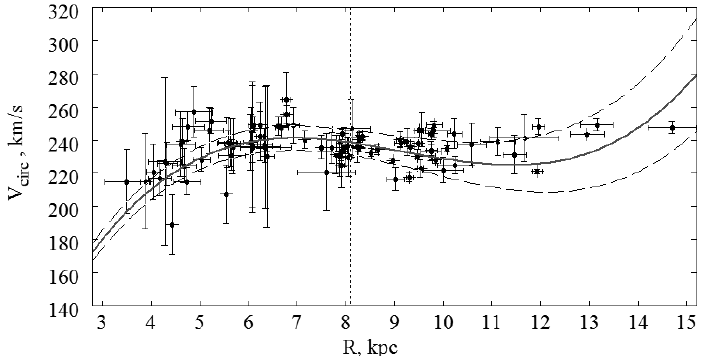
Fig. 2. Galactic rotation curve computed with parameters (8) (thick line); the thin lines mark the 1 (cid:27) confidence region; the vertical straight line indicates the position of the